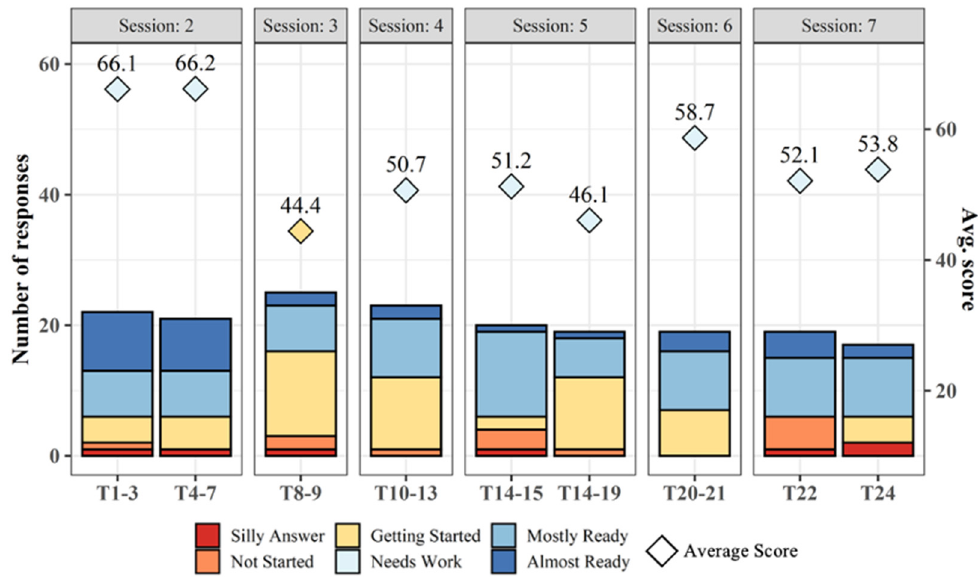
Figure 6. Responses to status of Tasks 1–24 (source: based on the polling survey results).